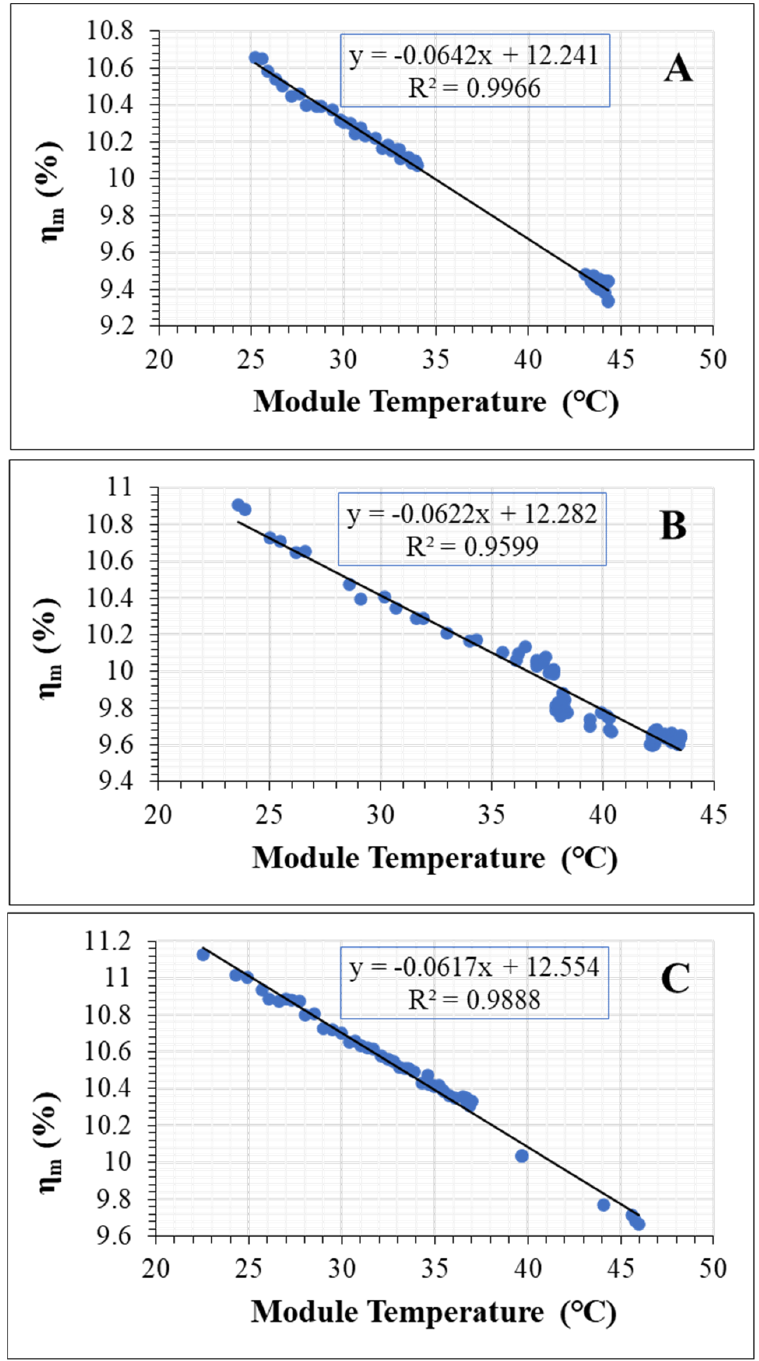
Figure 10. The relationship among the efficiency ( η m ), module temperature, and temperature coefficient of efficiency( β ηm ) of the 3 solar panels. R 2 indicates the degree of correlation.